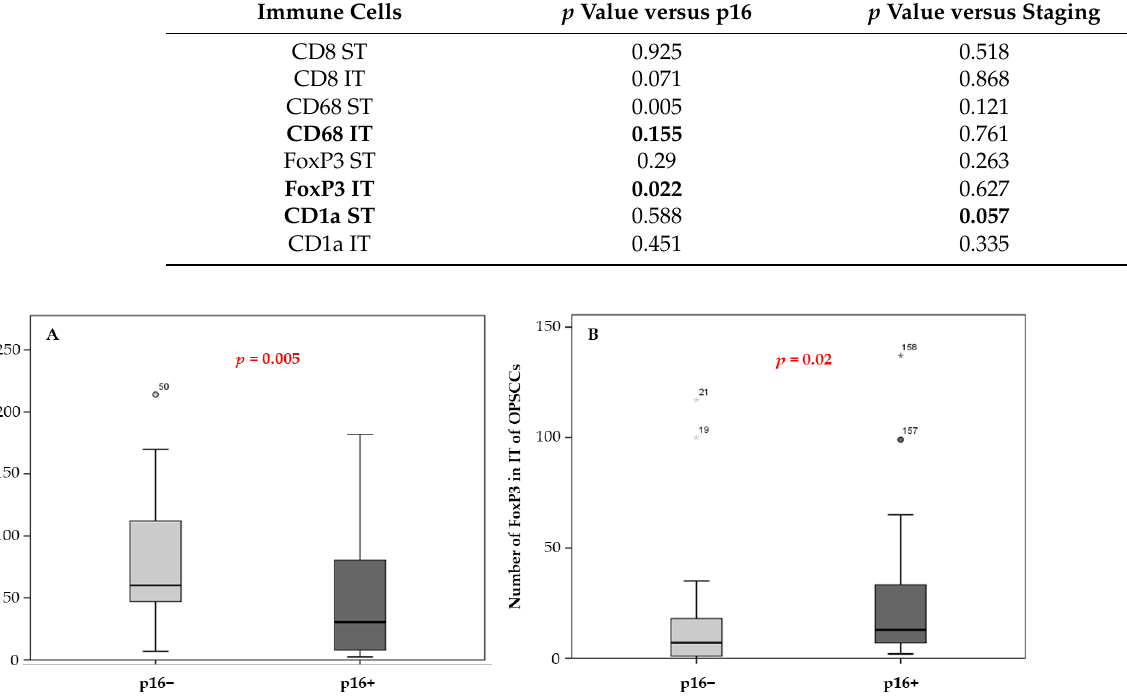
Figure 2. Evaluation of CD68 macrophage number in the ST compartment ( A ) and FoxP3 number in the IT area ( B ) of oropharyngeal tumors according to p16 status (Mann‒Whitney U test, p = 0.005 and p = 0.02, respectively) (*) asterisk symbols correspond to extreme atypical values.